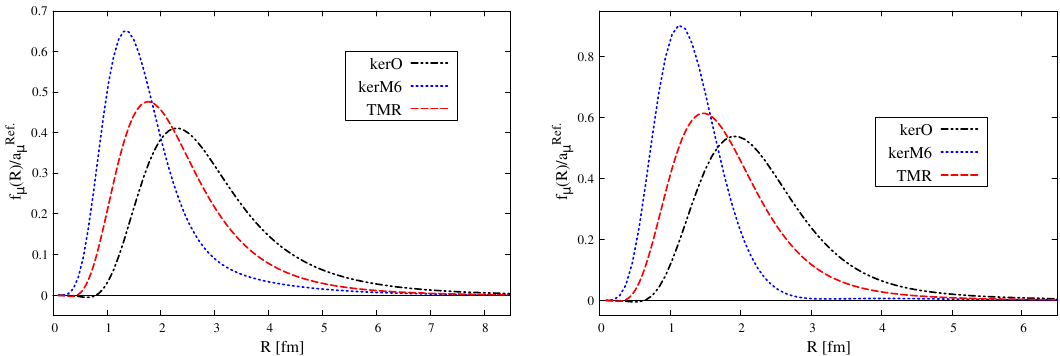
Figure 6 . Comparison between the normalized integrands from different representations of the π 0 -exchange contribution to a (cid:22) for Λ = 3 m µ (left panel) and Λ = 200 m µ (right panel), where ‘kerO’ is obtained with the original coordinate-space kernel, ‘kerM6’ with improved kernel given in B, with the parameter M set to 6 in eq. (B.4). The integrands are normalized such that the area under the curves equals